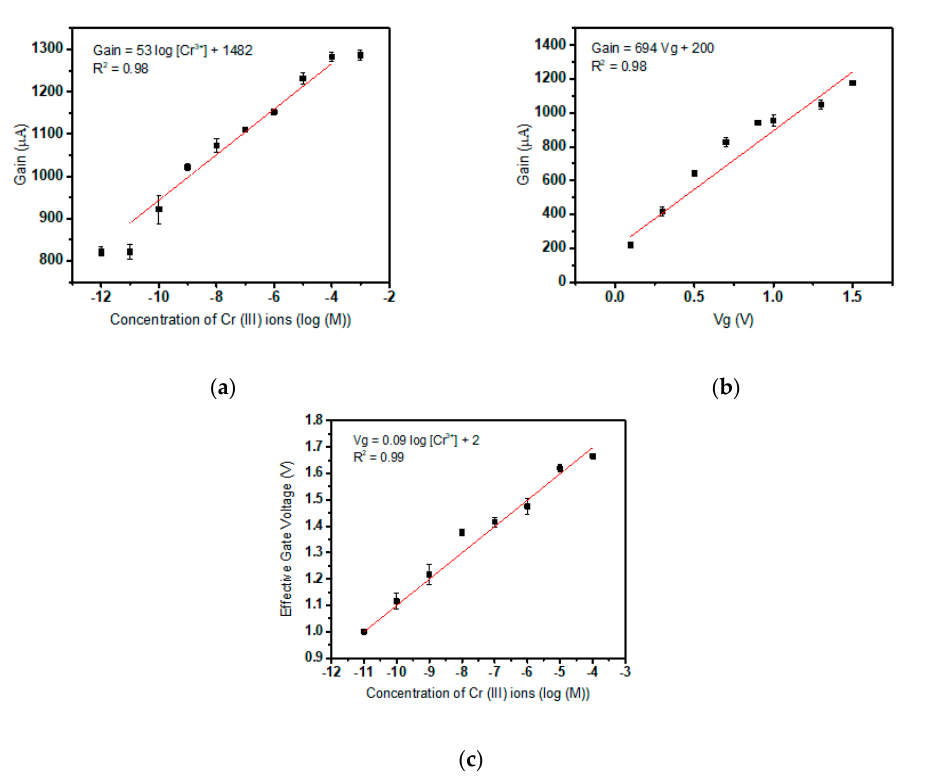
Figure 4. ( a ) Sensor detection curve of Cr(III) target ion; ( b ) Gain versus applied gate voltage in the absence of target ions; ( c ) Graph demonstrating sensitivity of the Cr(III) specific sensor.